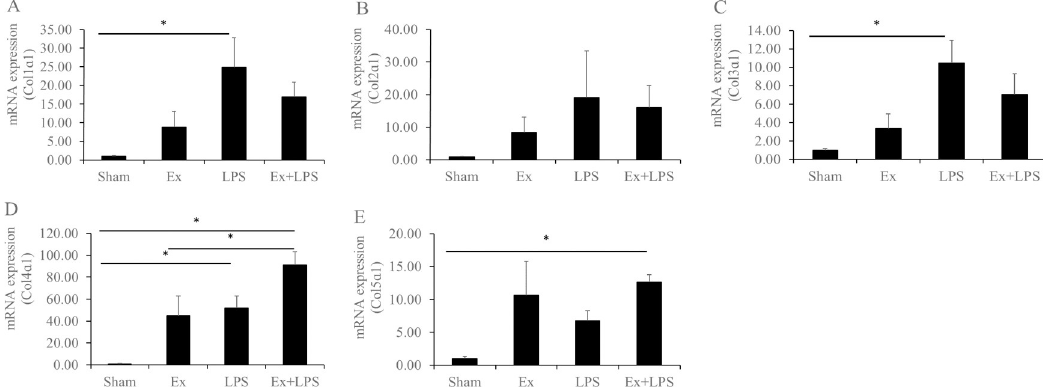
Fig 1. mRNA expression levels of the collagens, metalloproteinases, and tissue inhibitors of metalloproteinases. Data are presented as fold change. A) Col1 α 1, B) Col2 α 1, C) Col3 α 1, D) Col4 α 1, and E) Col5 α 1. � Statistically significant.